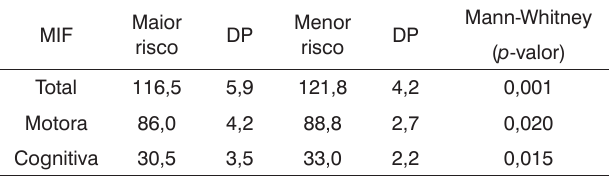
Tabela 2. Análise comparativa dos resultados médios da Medi- da de Independência Funcional (total, motora e cognitiva) para maior e menor risco de queda em 50 idosos com disfunções vestibulares periféricas crônicas.